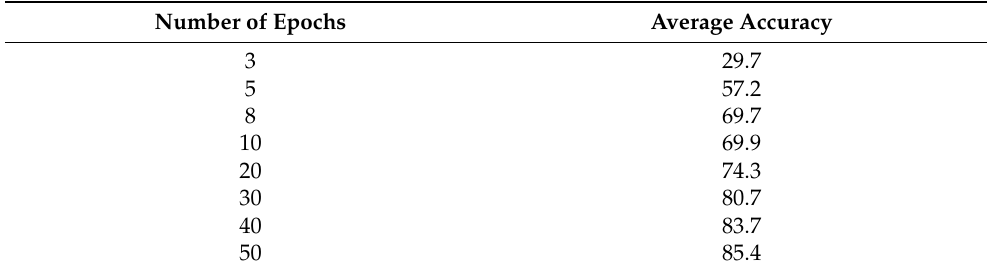
Table 3. Relationship between average accuracy (%) in data clustering and the number of epochs used in the VAE model.